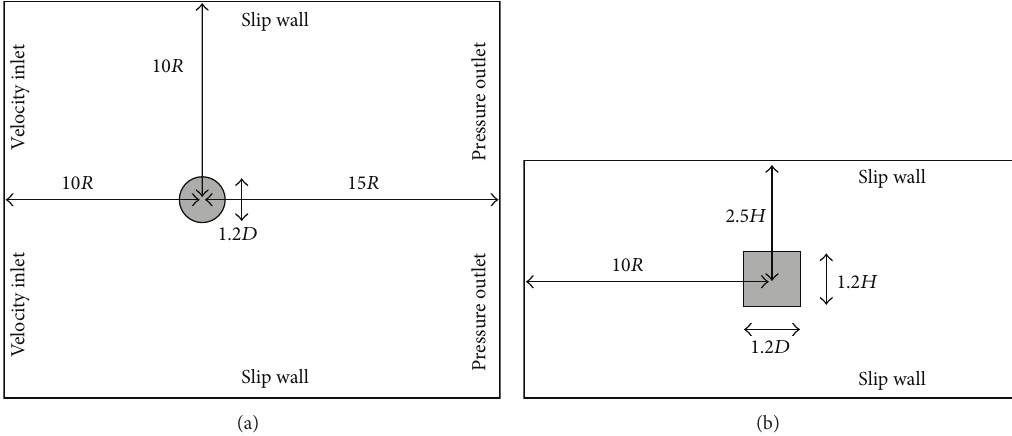
Figure 5: Upper view (a) and frontal view (b) of computational domain. The rotating region (in grey) inside the stationary one can be seen, along with their dimensions with respect to turbine radius 𝑅 , diameter 𝐷 , and height 𝐻 . Different boundary conditions are also shown.